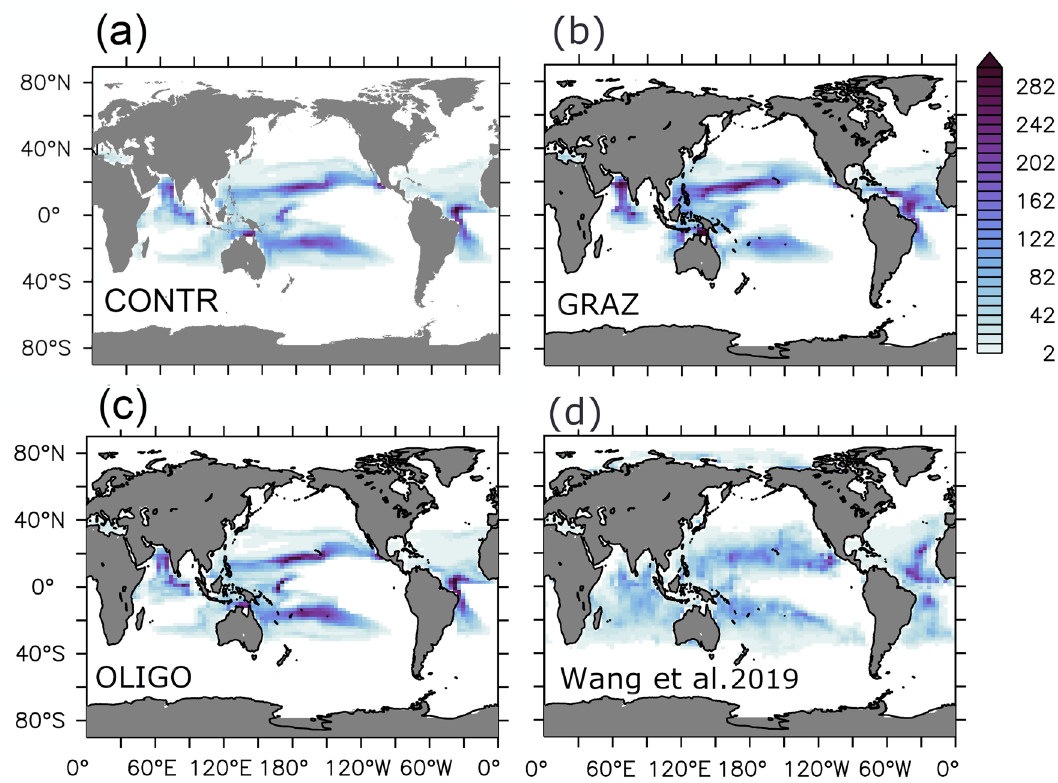
Figure 1. Annual mean nitrogen fixation rate in the water column in units mmol N/m 2 /yr. ( a – c ) refer to simulations CONTR, GRAZ and OLIGO, respectively. ( d ) refers to an observation-based estimate 7